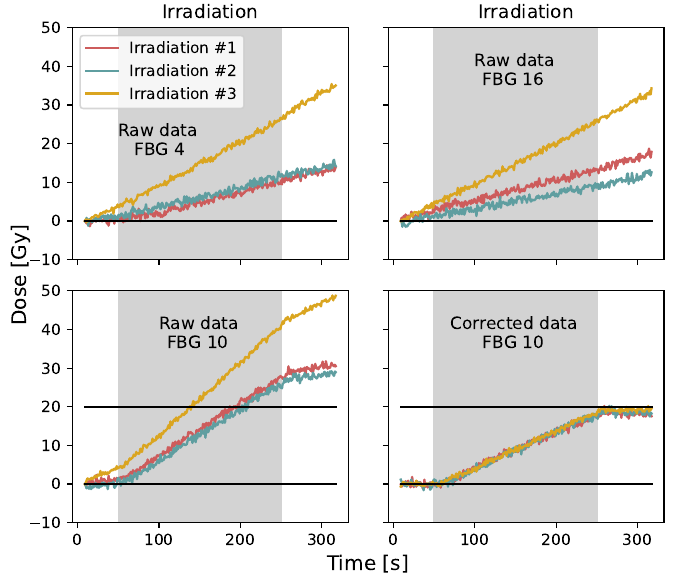
Figure 7. Raw data for FBG #4, #16, #10 and corrected data for FBG #10 for three different irradi- ation. Irradiations #1 and #2 were performed on the same day, and irradiation #3 was performed approximately one month later.